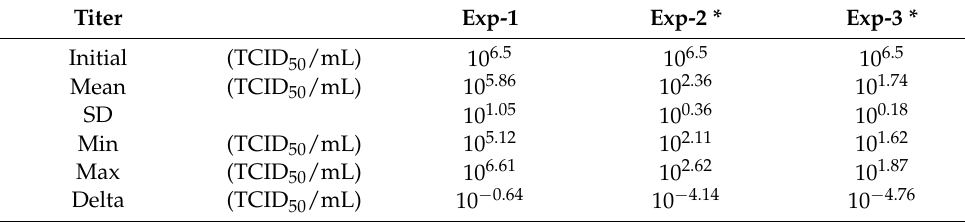
Table 1. Antiviral activity of hypertonic saline, coated on surgical masks.